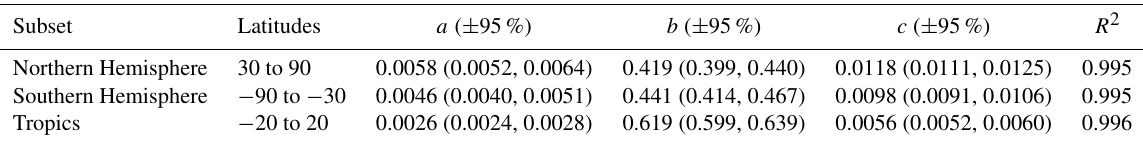
Table 2. Model parameters of tropical and extratropical clouds, for v = ad b + c , with confidence bounds and R squared coefficients.